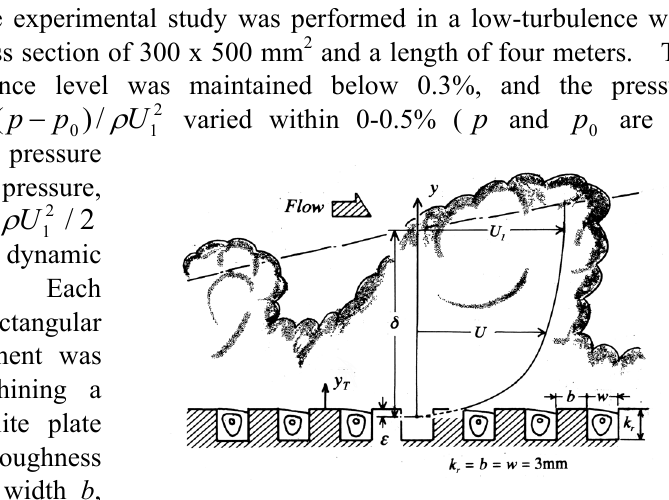
Fig.1 Flow field, coordinate system